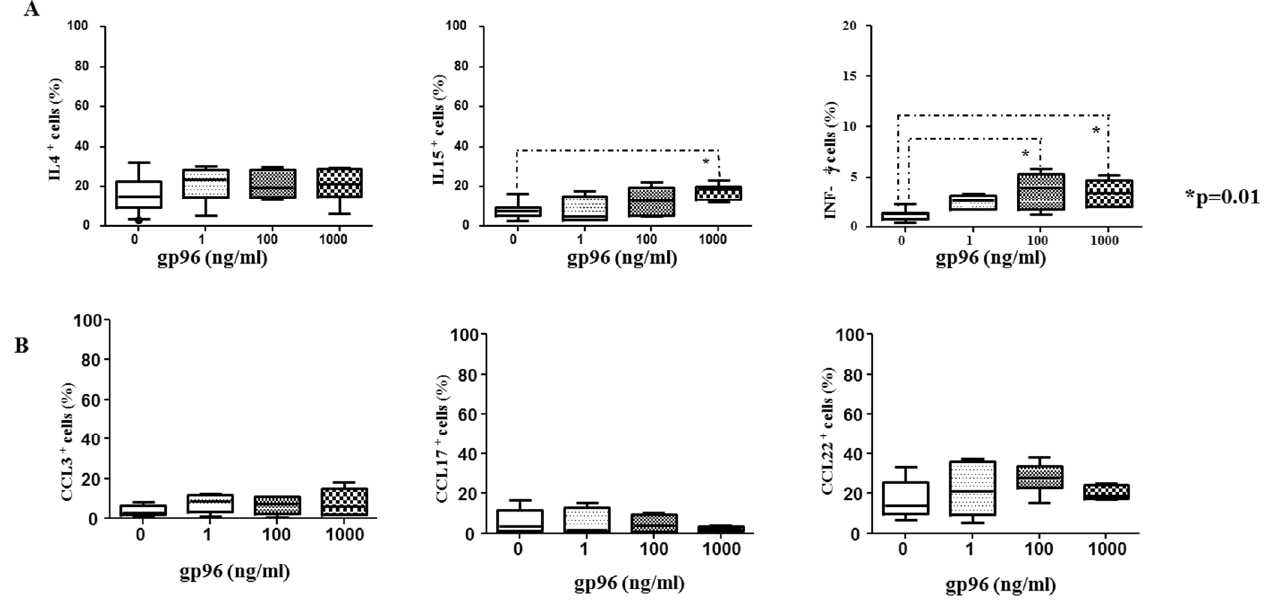
Figure 6. The percentages of intracellular cytokines interleukin (IL)-4, interferon-gamma (IFN- γ ) or IL-15 and chemokines CCL3, CCL17, or CCL22 expressing CD1a + cells from the suspensions of early decidual mononuclear cells after the 18 h—culture in the medium only or with gp96 at indicated concentrations are shown in the graphs ( A , B ). 7–8 independent experiments were performed in each group. Levels of statistical significance: * p = 0.01.